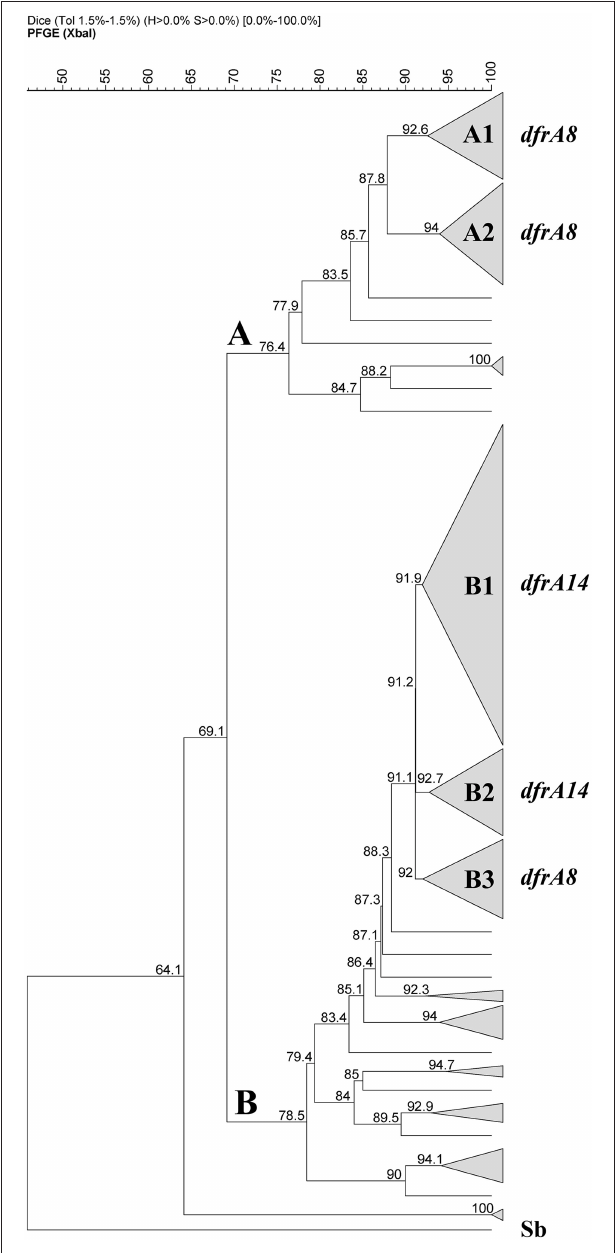
FIGURE 4 | Dendrogram based on Dice coefficients of similarity for 126 TMP-resistant Shigella sonnei strains. The dendrogram was constructed by UPGMA (GelCompar II). Figure shows two pulsogroups (A,B) with a similarity of 69.1%. Twenty-three pulsotypes were defined with a similarity > 91%. Within the pulsogroup A, most of the strains were grouped in A1 and A2 pulsotypes, both containing dfrA8 as TMP-resistance marker. Within the pulsogroup B, most of the strains were clustered in three pulsotypes, B1 and B2 include the dfrA14 -positive strains and B3 dfrA8- positive strains isolated before the outbreak. Sb, strain of Salmonella serotype Braenderup, digested with Xba I as a size marker.